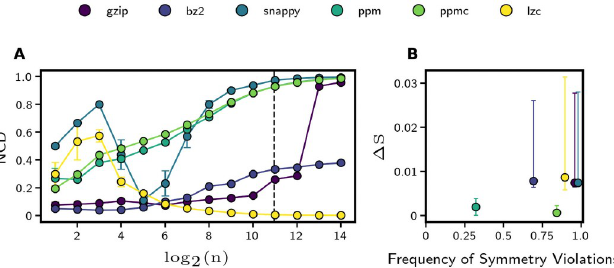
Fig 6. Compressor idempotency and symmetry. Five different compression algorithms were tested for idempotency and symmetry in the normalized compression distance metric: the widely used “gzip” and “bz2,” two different prediction by partial matching implementations “ppm” and “ppmc,” and Google’s “Snappy.” The Lempel-Ziv complexity was also used as a proxy for compressed length in NCD calculation. Panel A shows the average NCD between ten binomial random sequences ( p = 0.5) and themselves for different sequence lengths (ideally, the NCD should be close to zero). Error bars indicate the standard error of the mean. The dashed vertical line indicates the length of the spike trains analyzed in the rest of this study. Panel B shows size of symmetry violation (see Eq 9) against the frequency of a violation for 1,000 different pairs of binomial random sequences ( p = 0.5). Error bars indicate 95% confidence